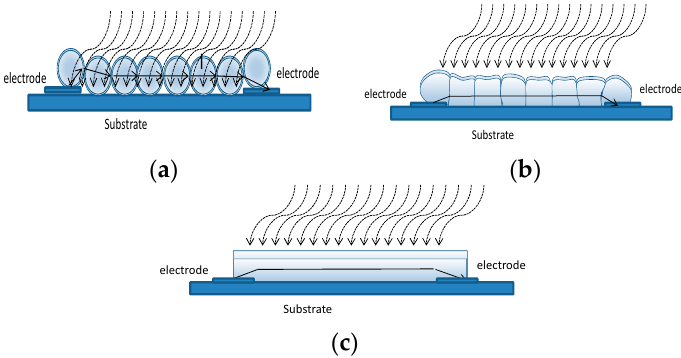
Figure 13. Sensor structure and model. ( a ) Porous layer. ( b ) Dense layer. ( c ) Compact layer.